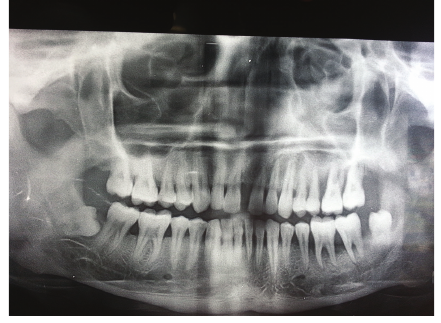
Figure 1: Gingival hyperplasia on left side of maxillary arch.